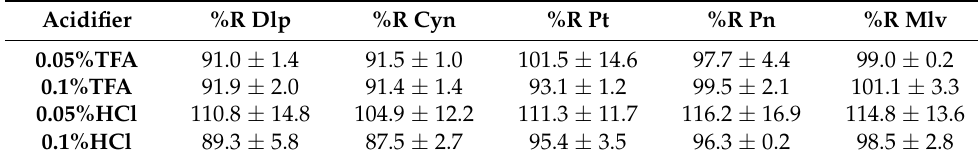
Table 1. Recovery (%) of anthocyanins extracted with different acidified solvents.